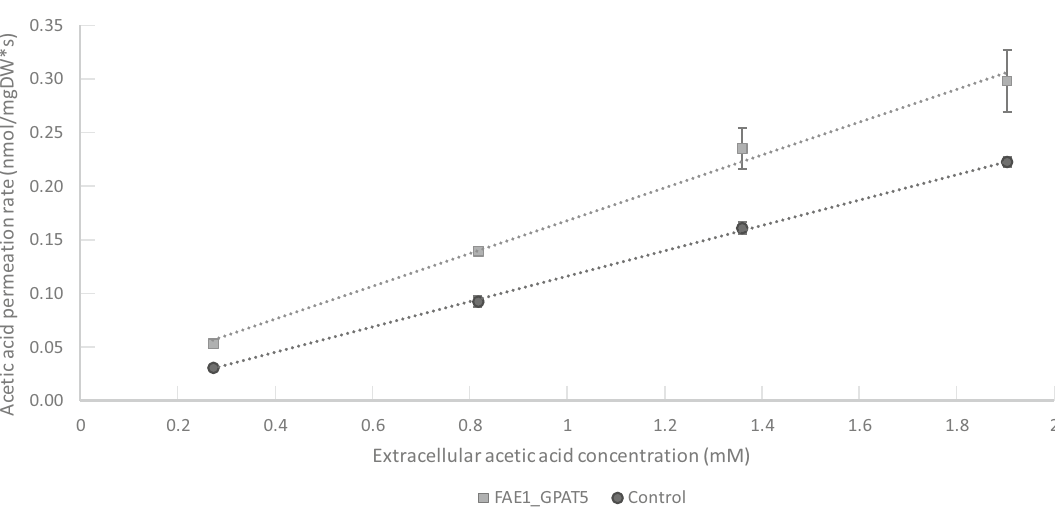
Figure 5. Acetic acid uptake kinetics. The FAE_GPAT5 strain (light grey) and the control strain (dark grey) are shown. Additionally, a linear regression line is shown. The slope of the regression lines is as followed: for FAE1_ GPAT5 0.15 (σ 0.02) and 0.118 (σ 0.002) for the control strain. A linear correlation between the extracellular acetic acid concentration (mM, x-axis) and the acetic acid permeation rate (nmol/(mg dry weight x s), y-axis) would suggest that acetic acid uptake occurs predominantly as passive diffusion. The slope of a linear correlation curve is indicative of the net uptake